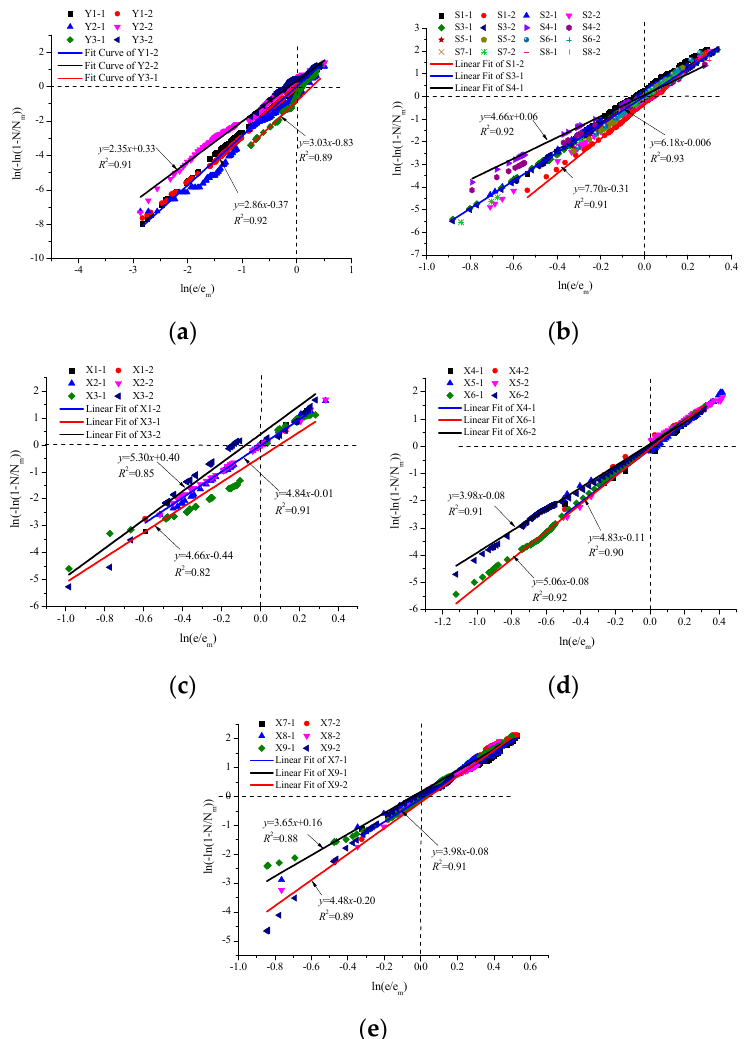
Figure 16. The fitting relationship between ln ( − ln ( 1 − N / N m )) and ln ( ε / ε m ) in experiments of three materials. ( a ) Raw coal; ( b ) cement; ( c ) shaped coal (less than 0.25 mm); ( d ) shaped coal (0.25–0.50 mm) and ( e ) shaped coal (0.50–2.00